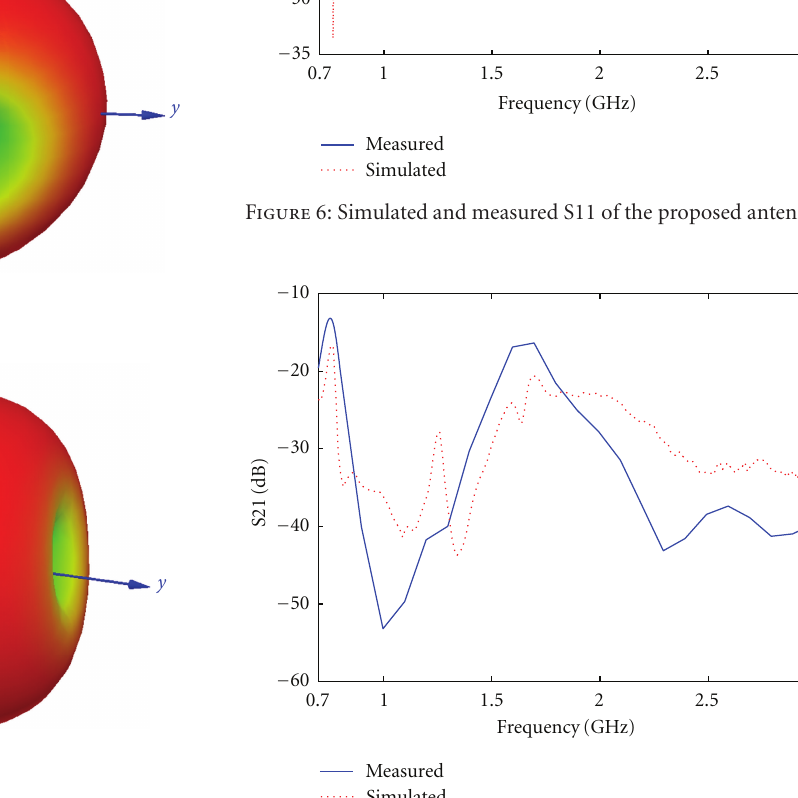
Figure 7: Simulated and measured S21 of the proposed